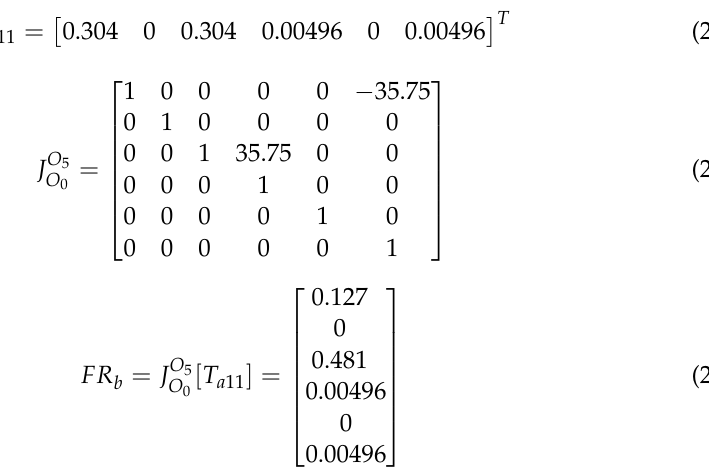
Figure 6. Local coordinates of cutter holder and disc cutter. According to the accuracy requirements, the tolerance field spinor of T 3 is as follows. 6